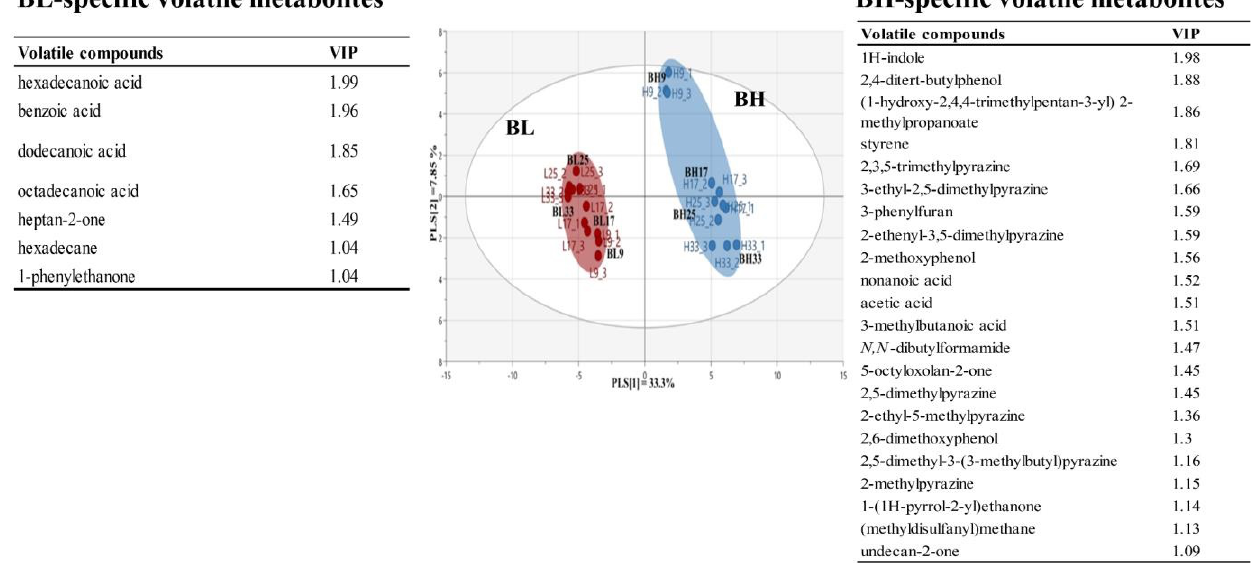
Figure 2. Multivariate statistical model by PLS-DA score plot based on volatile metabolite profiles, and the list of main variables representing BH or BL.